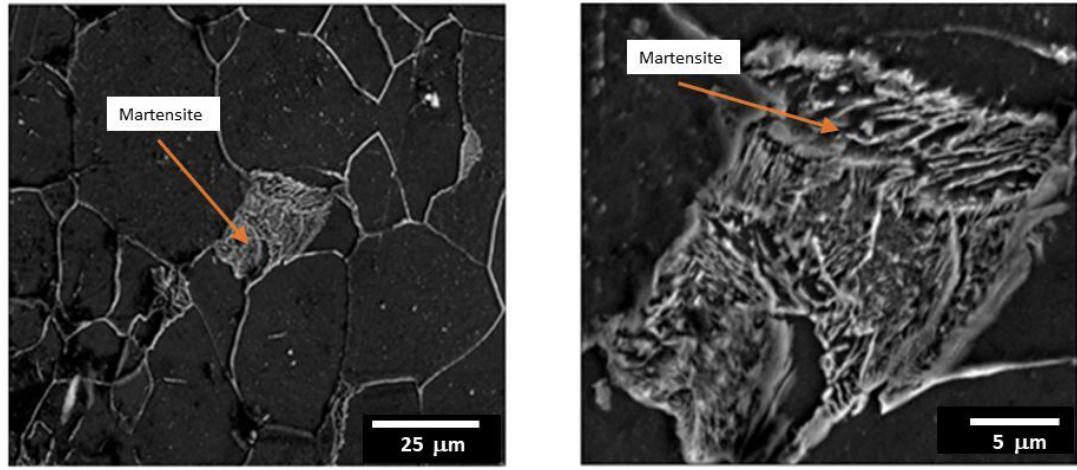
Figure 16. Microstructure of 1008 steel deformed at 800°C, 1000X and 4000X, strain rate 10 -2 s -1